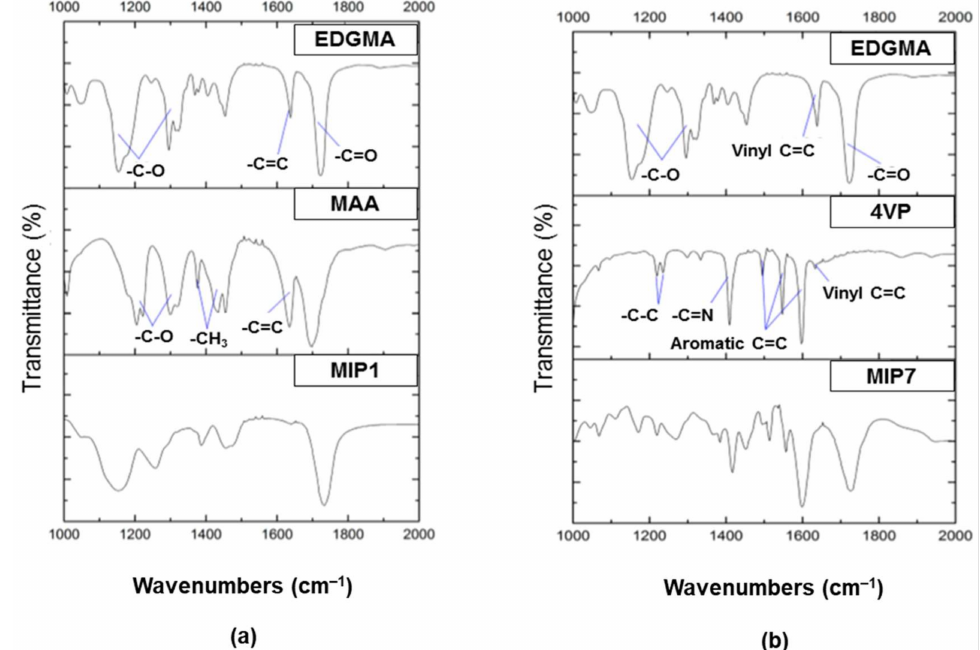
Figure 13. ( a ) FT-IR spectra collected for the MIP1 product (synthesized with MAA as functional monomer and EGDMA as crosslinker); ( b ) FT-IR spectra collected for the MIP7 product (synthesized with 4VP as functional monomer and EGDMA as crosslinker) [61].